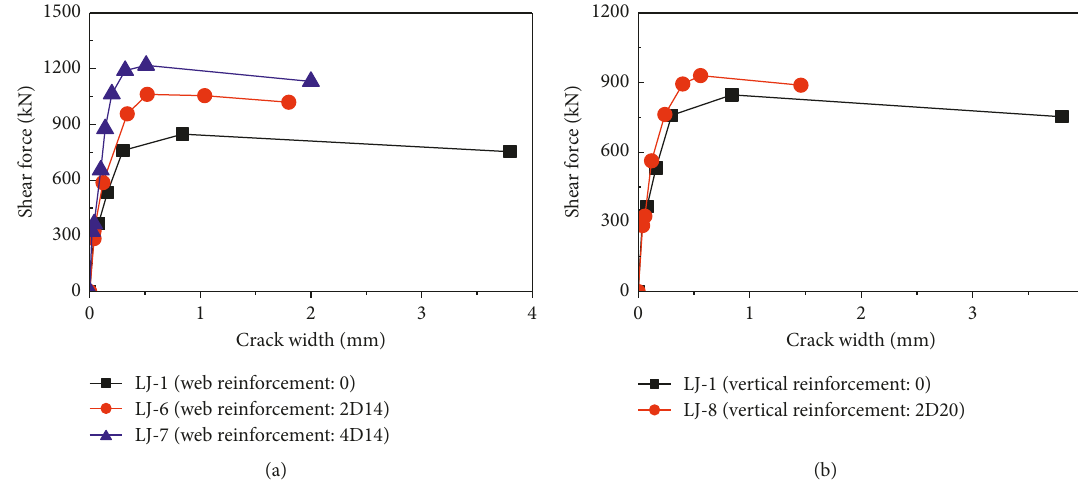
Figure 4: The influence of web reinforcement in the beam and noncorner vertical reinforcement in the column on the crack width of joints. The influence of (a) web reinforcement in the beam and (b) noncorner vertical reinforcement in the